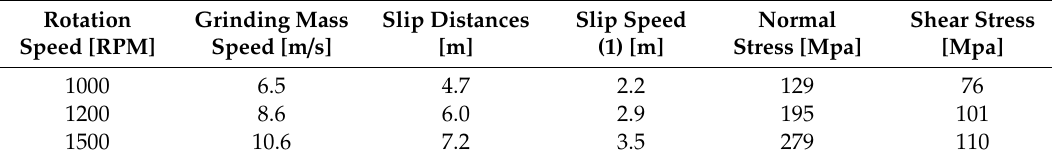
Table 1. Slip velocity, slip distances, normal stress, and shear stress during milling in a vibrating cup mill from